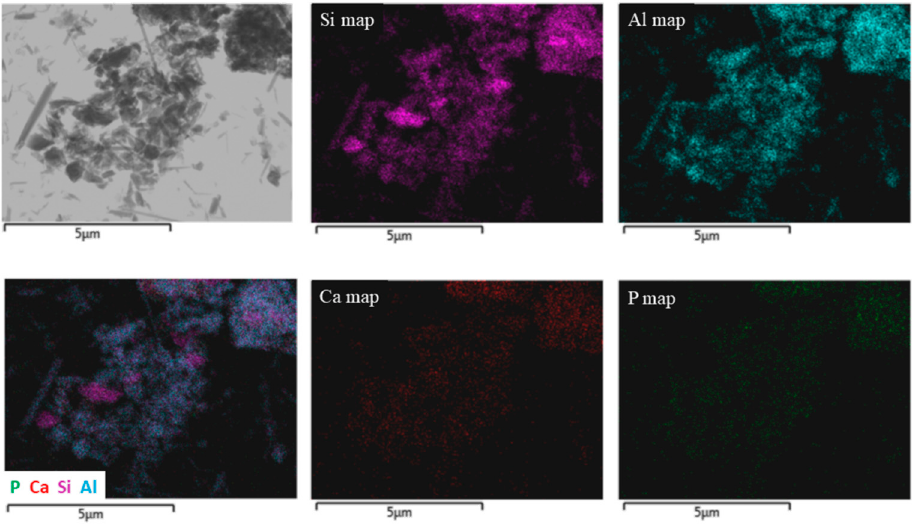
Figure 3. TEM image and EDX mapping of HNTs/Ca(OH) 2 with calcium phosphate end-stoppers.